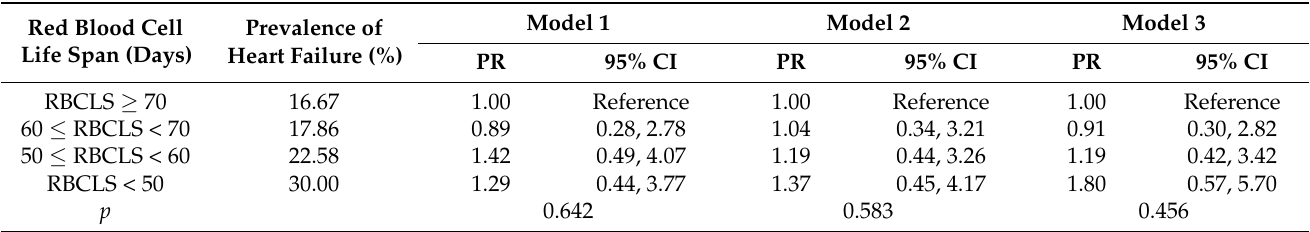
Table 4. Association analysis of different RBCLS rates with heart failure at the end of follow-up.